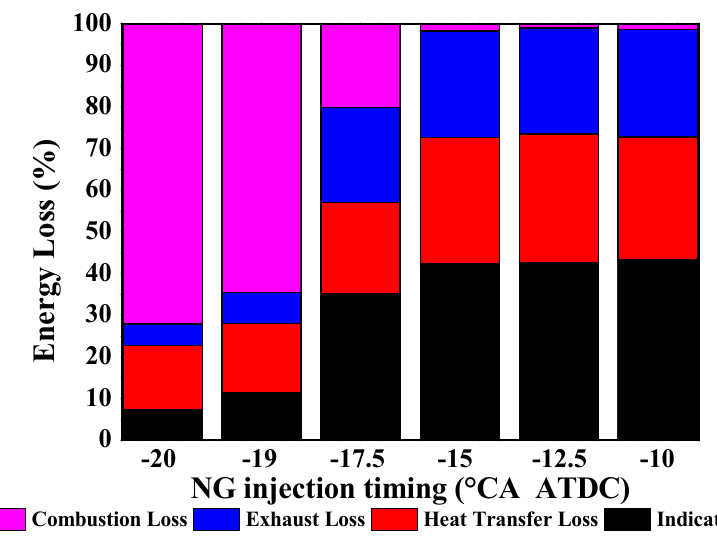
Figure 19. Distribution of energy loss.